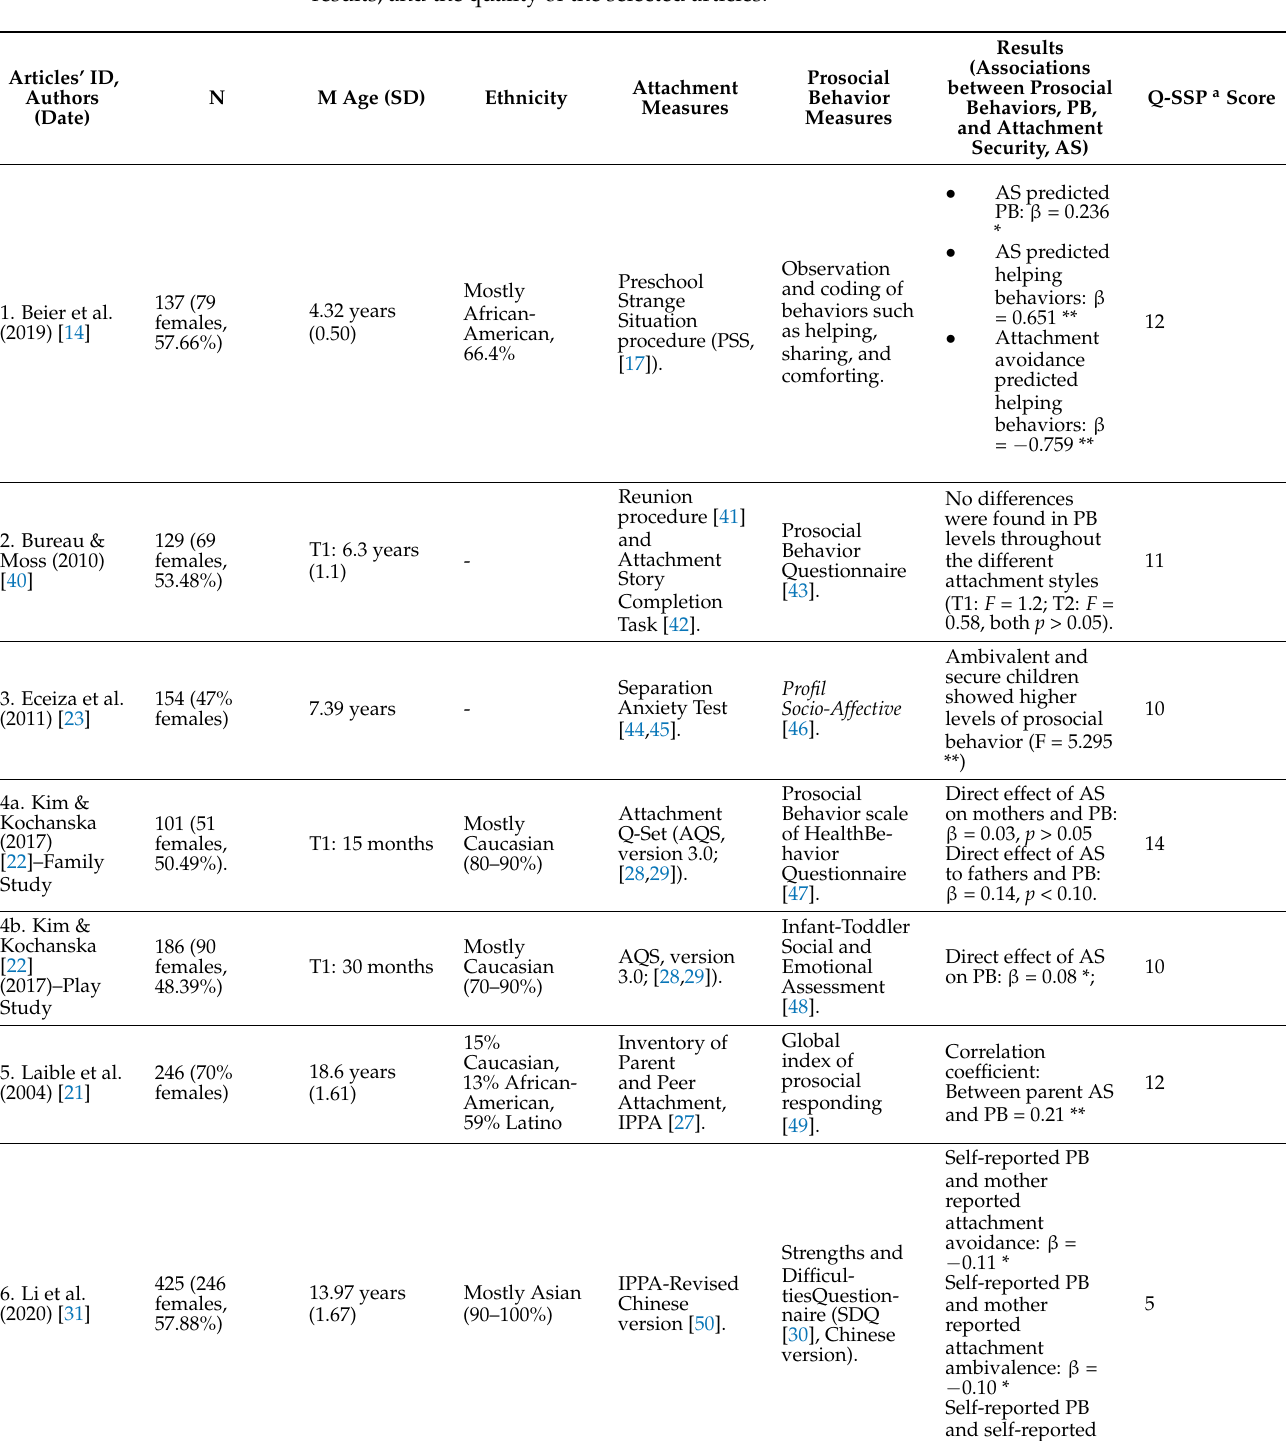
Table 3. Synthesis of the sample dimensions, the participants’ age and ethnicity, the instruments, the results, and the quality of the selected